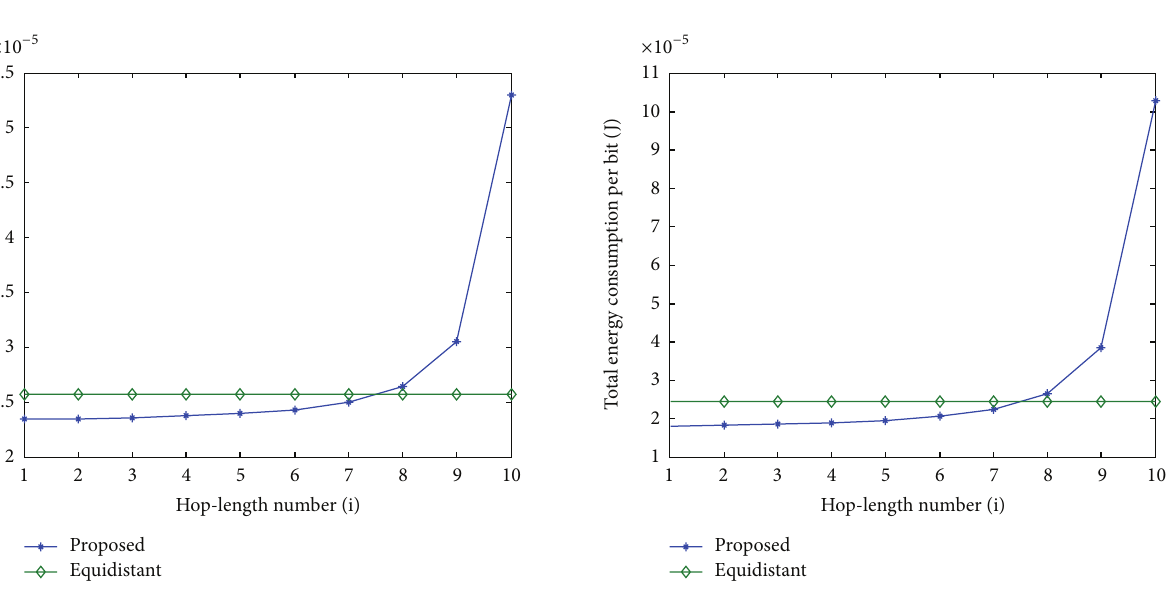
Figure 15: Total energy consumption per bit for each cluster, 4bits transmission.